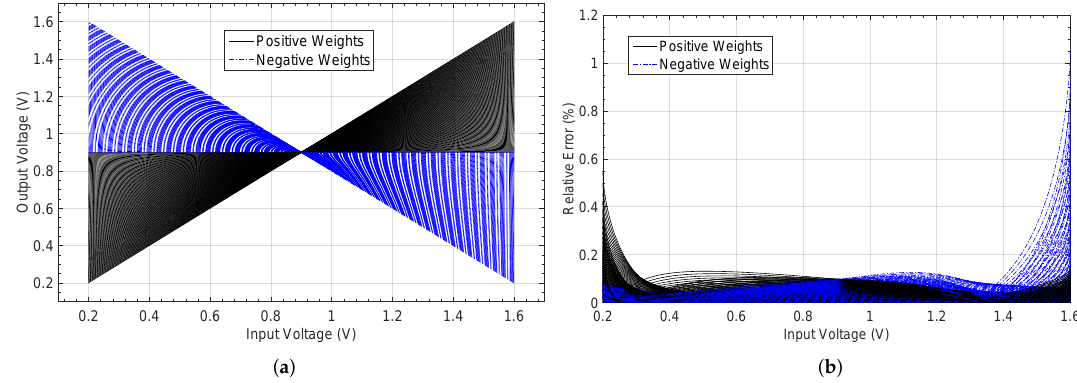
Figure 6. High-level simulated mixed-mode 8-bit multiplier operation: ( a ) model response and ( b ) relative error by comparing with the electrical